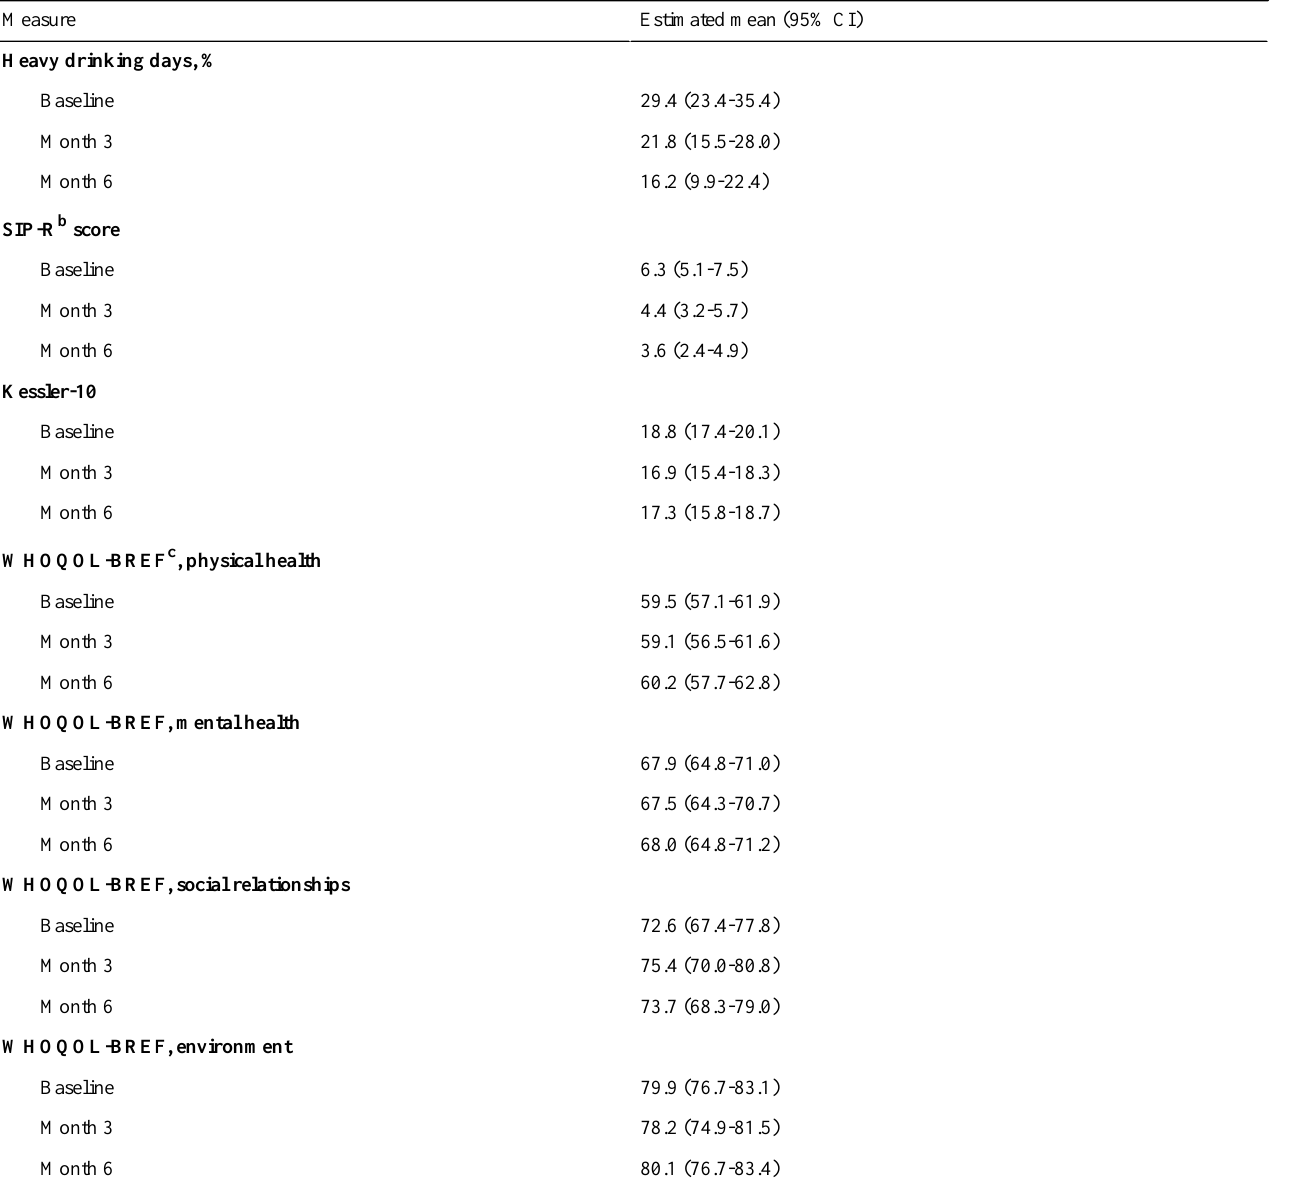
Table 4. Estimated alcohol use, psychological distress, and health-related quality of life scores over time.